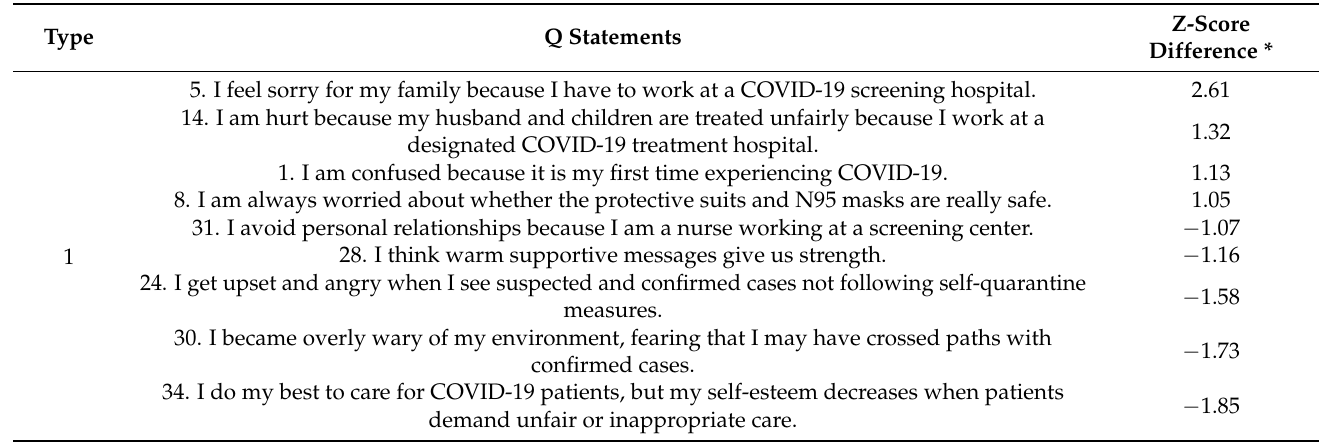
Table 5. Z-Score differences between